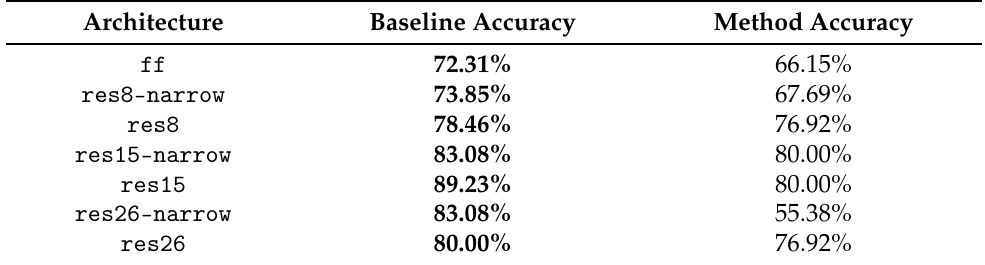
Table 12. Test accuracy after using the Google Speech Commands data set [38] as additional unknown samples. The best result for each architecture is highlighted.